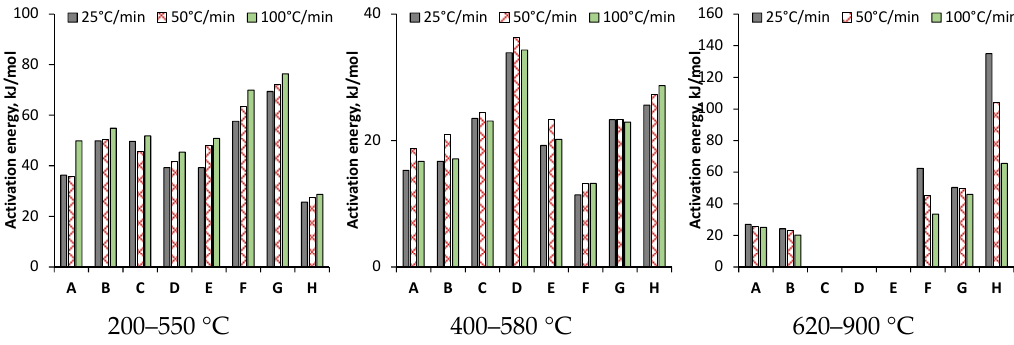
Figure 4. The activation energies of the sample decompositions.